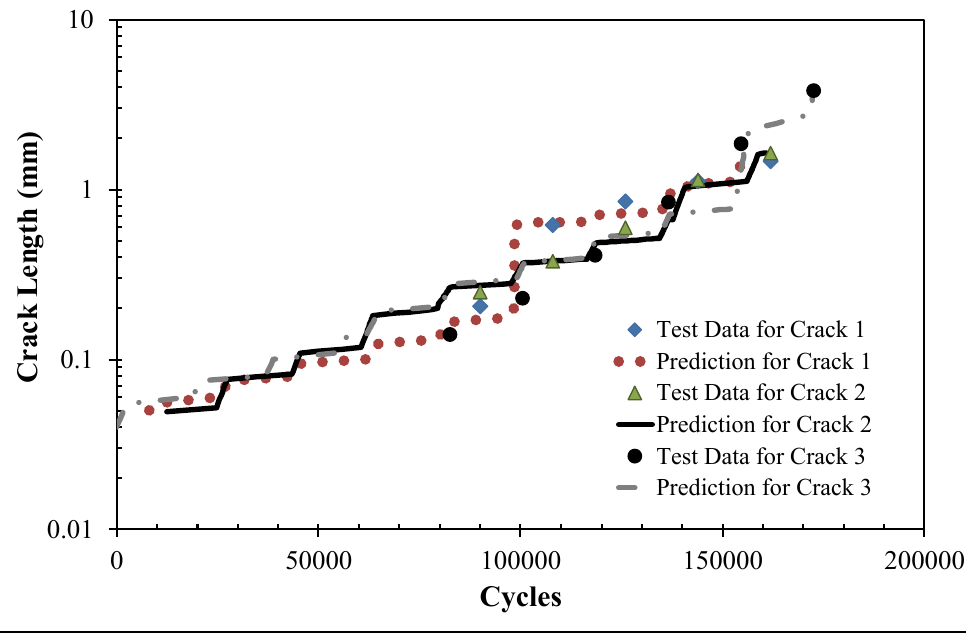
Figure 22. Measured and computed crack length histories for cracks 4–6 in specimen DNHS ‐ 1 ‐ 12. As such, it appears that as in [46], which found that the crack growth histories associated with the fastest growing (small) cracks in seven different cold spray repair specimens could be captured without allowing for the effect of the residual stresses that are induced both in the cold spray and the substrate as a result of the deposition process, the growth of these six different co ‐ located small cracks